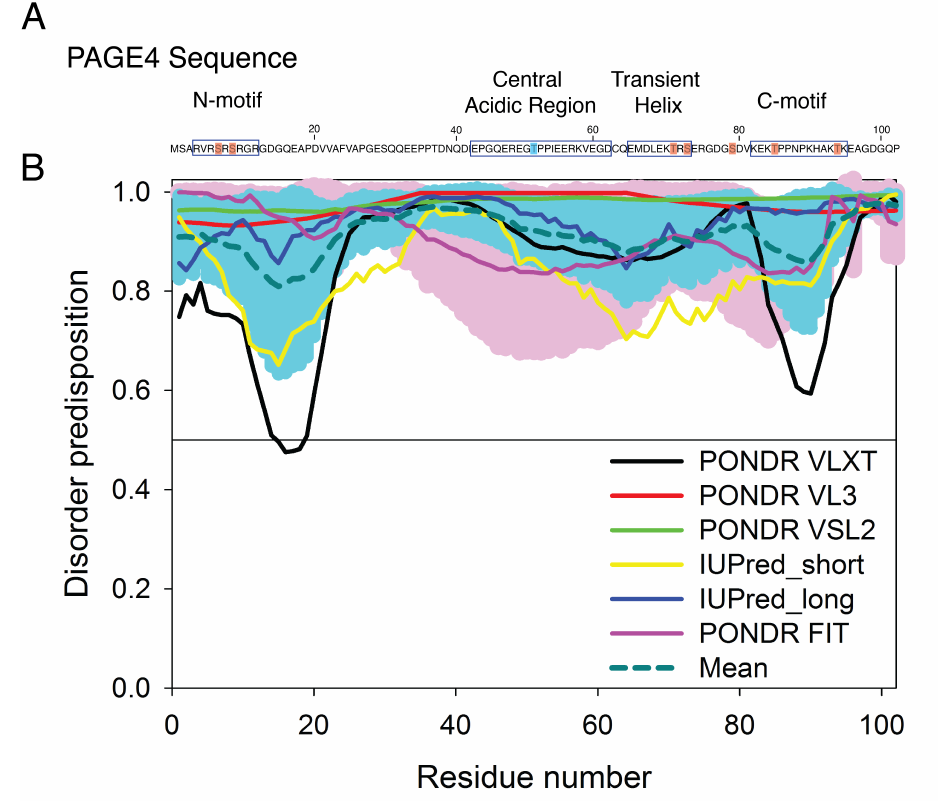
Figure 1. The sequence of prostate-associated gene 4 (PAGE4) and the evaluation of its intrinsic disorder propensity. ( A ) The sequence of PAGE4. The sites phosphorylated by HIPK1 are highlighted in blue, and those phosphorylated sites by CLK2 are highlighted in red. All phosphorylated sites were modeled in the AAWSEM simulation [35]. The N-motif (residues 4–12), Central acidic region (residues 43–62), transiently helical region (residues 65–73) and C-motif (residues 82–95) are also indicated by square box. ( B ) The disorder propensity of PAGE4 was calculated by several per-residue disorder predictors, such as PONDR ® VLXT (black line), PONDR ® VL3 (red line), PONDR ® VSL2 (green line), IUPred_short (yellow line), IUPred_long (blue line) and PONDR ® FIT (pink line). The dark cyan dashed line shows the mean disorder propensity calculated by averaging disorder profiles of individual predictors. Light pink and cyan shadows around the PONDR ® FIT and mean curve show the error distribution. In these analyses, the predicted intrinsic disorder scores above 0.5 were considered to correspond to the disordered